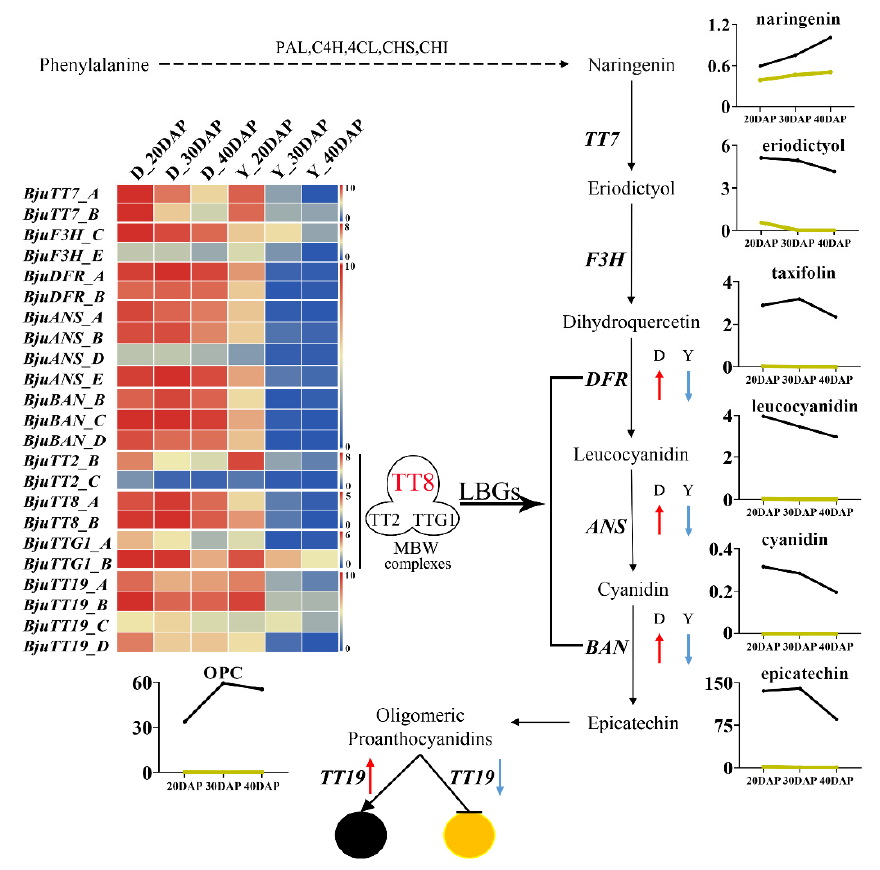
Figure 7. Schematic diagram of the flavonoid biosynthetic pathway in B . juncea . The scale bar denotes the log2 (FPKM+1). Table 1. 055). The color represents relative gene expression levels.